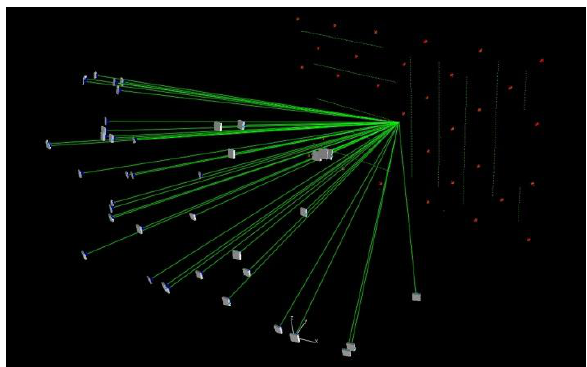
Figure 4. Object target array and camera configuration for the dataset taken with the Nikon